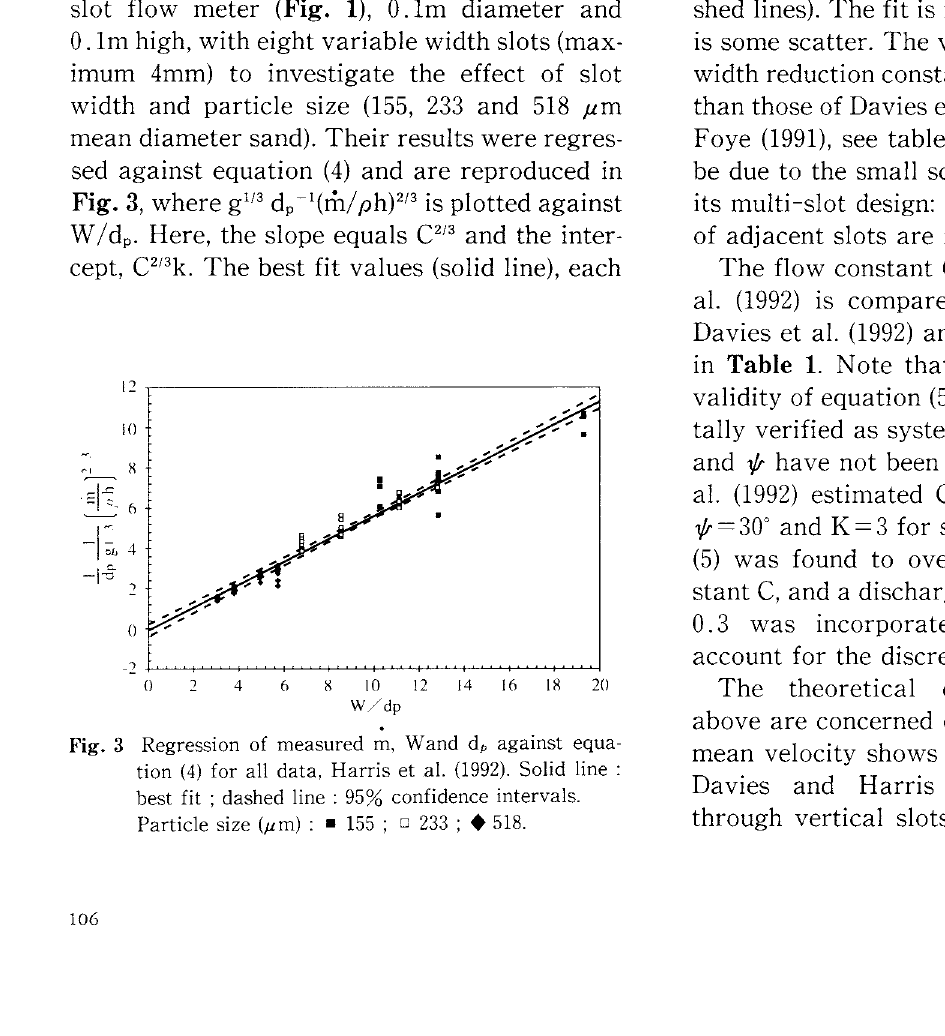
Fig. 2 Slot flow geometry for flow analysis (Harris et a!. (1992)).